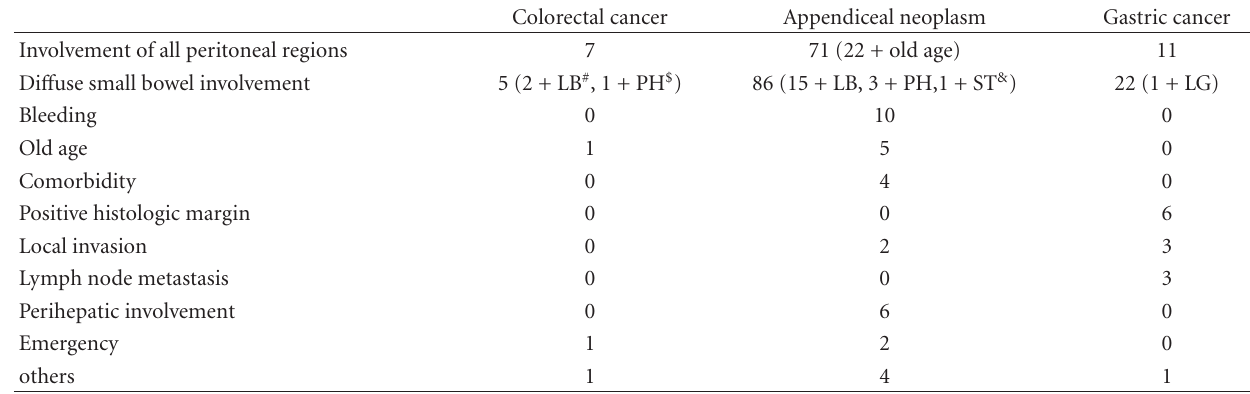
Table 2: The causes of CC-2,-3 resections. Colorectal